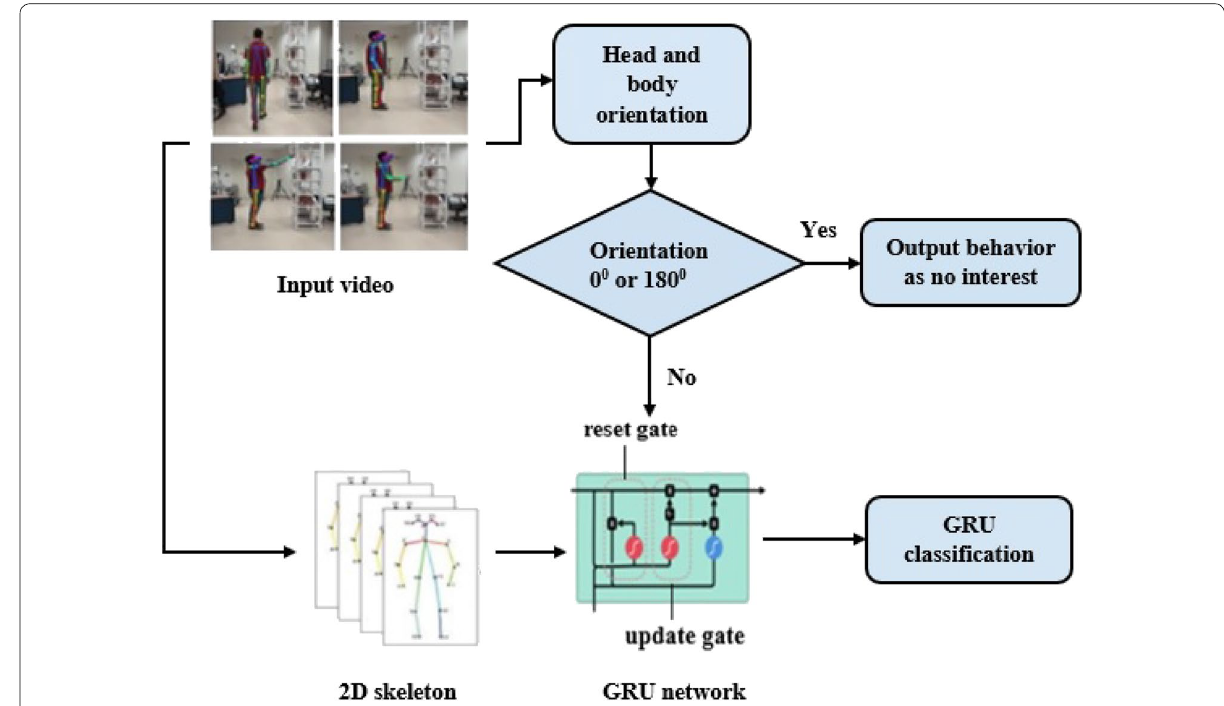
Fig. 2 Framework of customer shopping behavior classification system